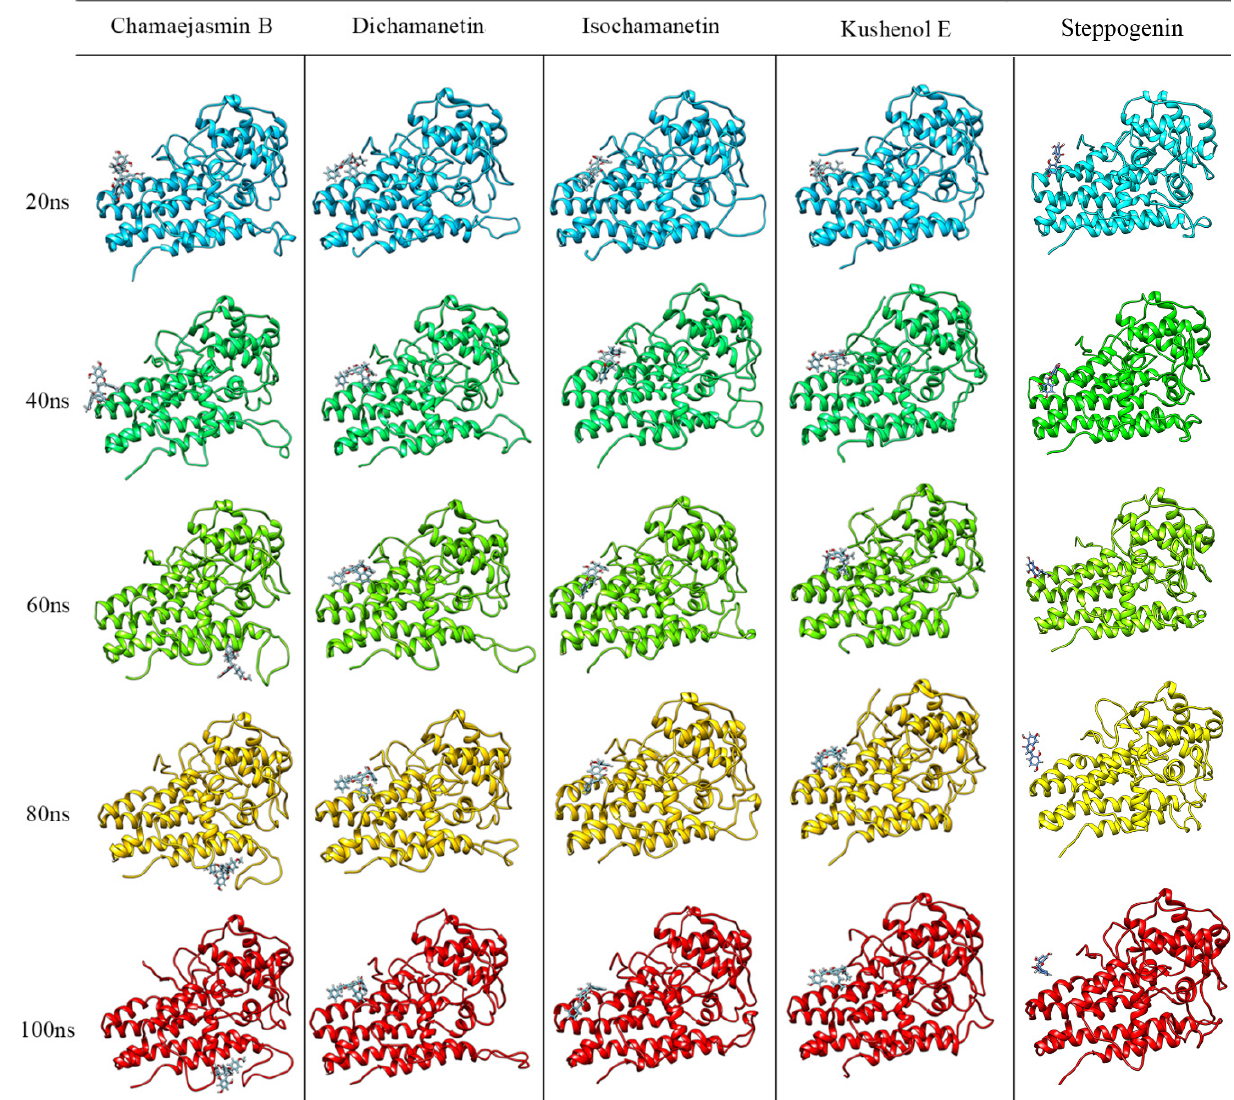
Figure 11. Conformational profile of the complexes formed by the interaction of IDO1 with chamae- jasmin B, dichamanetin, isochamanetin, Kushenol E, and steppogenin, respectively, up to 100 ns molecular dynamic simulations.